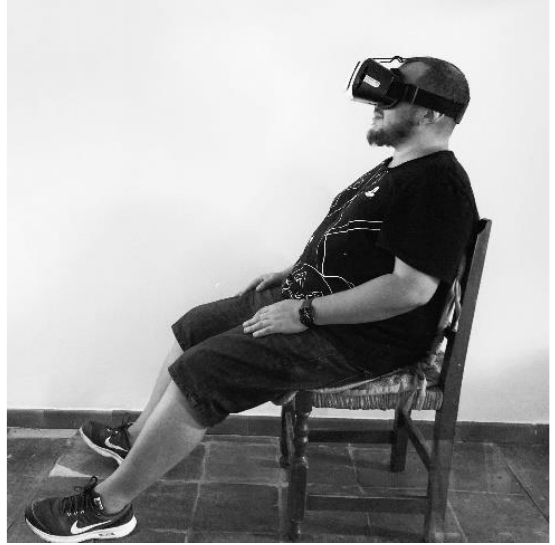
Figure 1. Patient completing the 180° immersive VR motion visualization intervention.